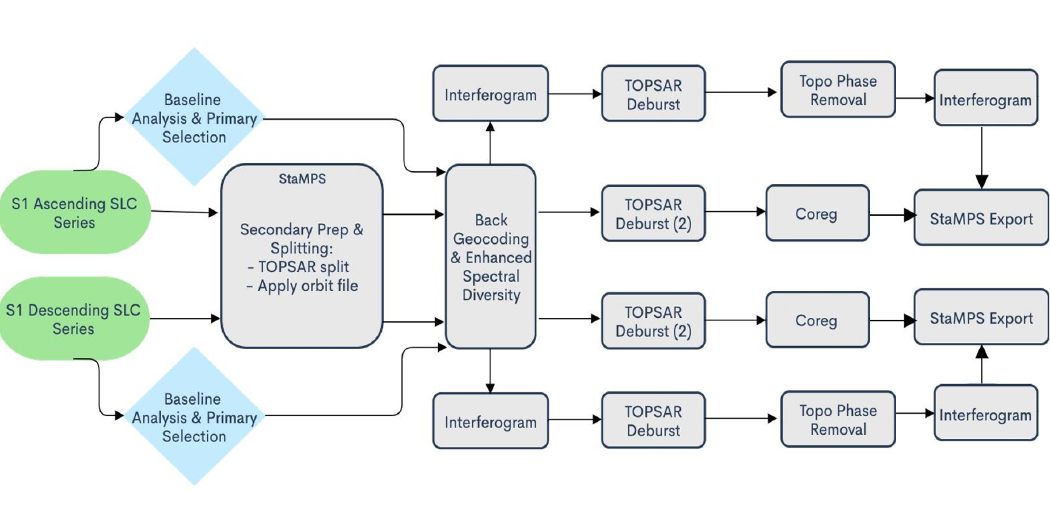
Figure 3. Schematic graph of all steps from preparation of interferometric inputs, to the StaMPS PSI processing, to finally the export before post-processing. The final StaMPS export yields LOS subsidence rates for both the ascending and descending